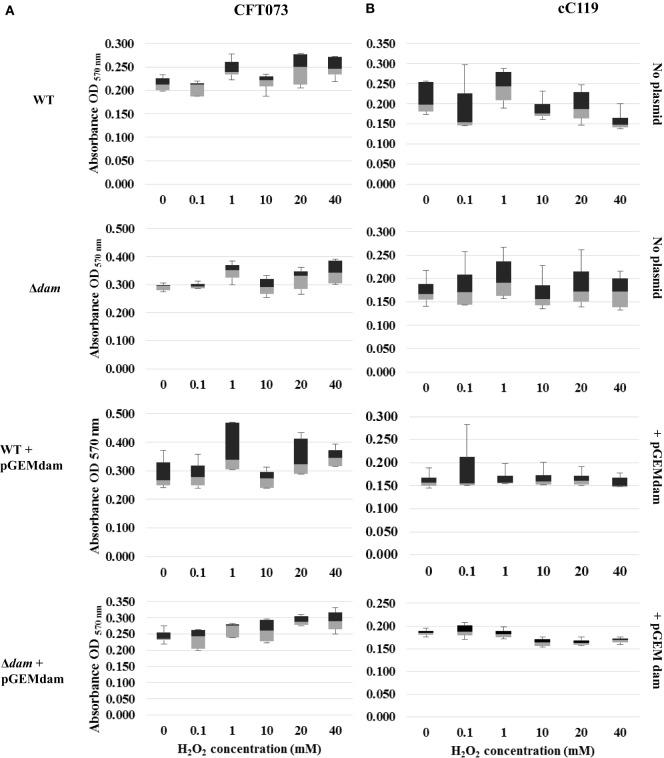
Distribution analysis of biofilm formation for wild type (WT), Δdam, WT + pGEMdam, and Δdam + pGEMdam UPEC strains of CFT073 (A) and cC119 (B) in various hydrogen peroxide (H2O2) concentrations.